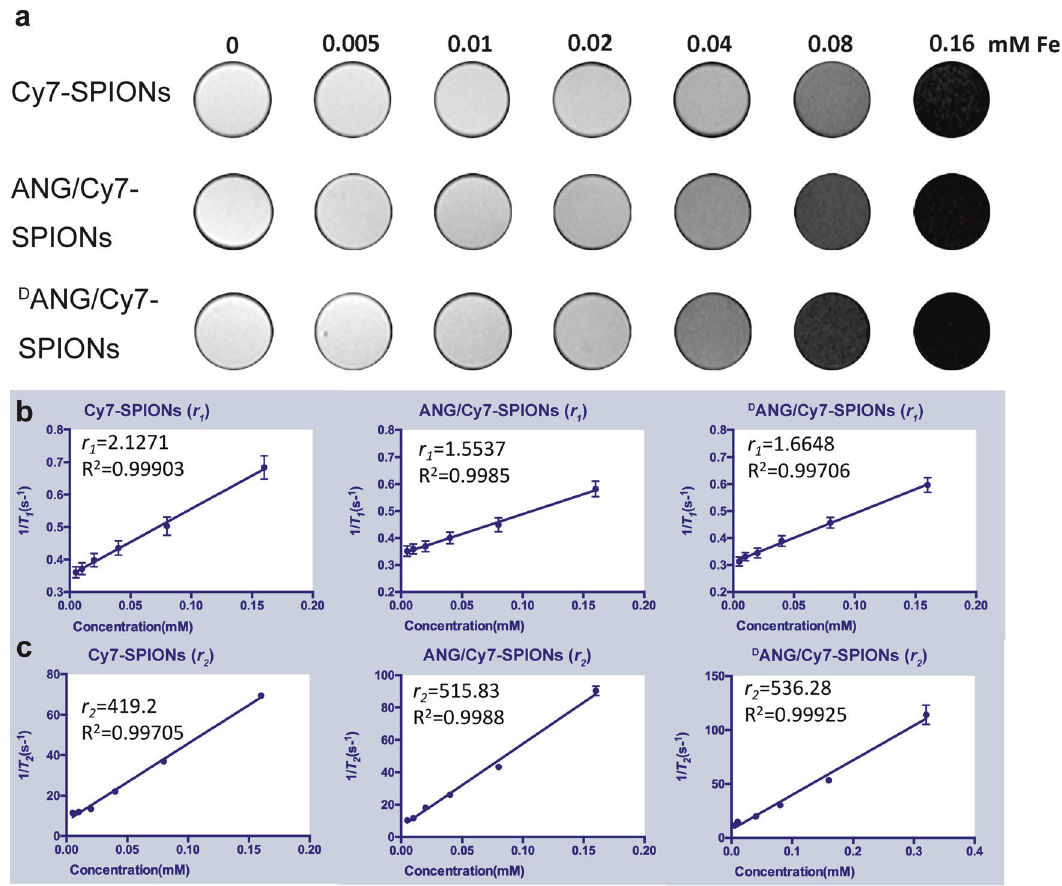
Fig. 3 a T 2 -weighted MRI of different concentrations of Cy7-SPIONs and peptide/Cy7-SPIONs probes in a 7.0 T magnetic fi eld; b The r 1 value of the Cy7-SPIONs probe and two peptide/Cy7-SPIONs probes in a 7.0 T magnetic fi eld; c The r 2 value of the Cy7-SPIONs probe and two peptide/ Cy7-SPIONs probes in a 7.0 T magnetic fi